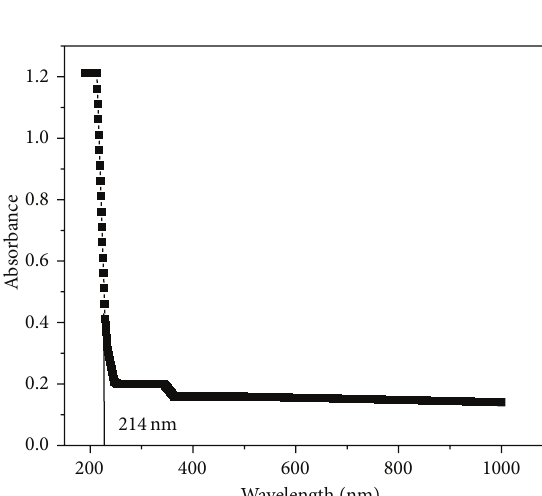
Figure 3: FT-IR spectrum of LSP crystal.